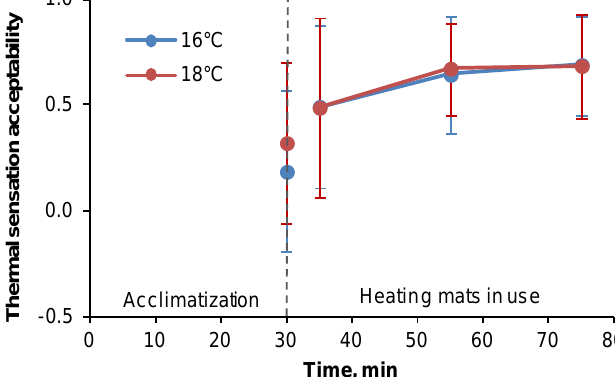
Figure 3. Average acceptability and standard deviation of thermal sensation during exposures at 16 and 18 °C. Thermal sensation acceptability: − 1—clearly unacceptable 0—just unacceptable/just acceptable, 1—clearly acceptable.